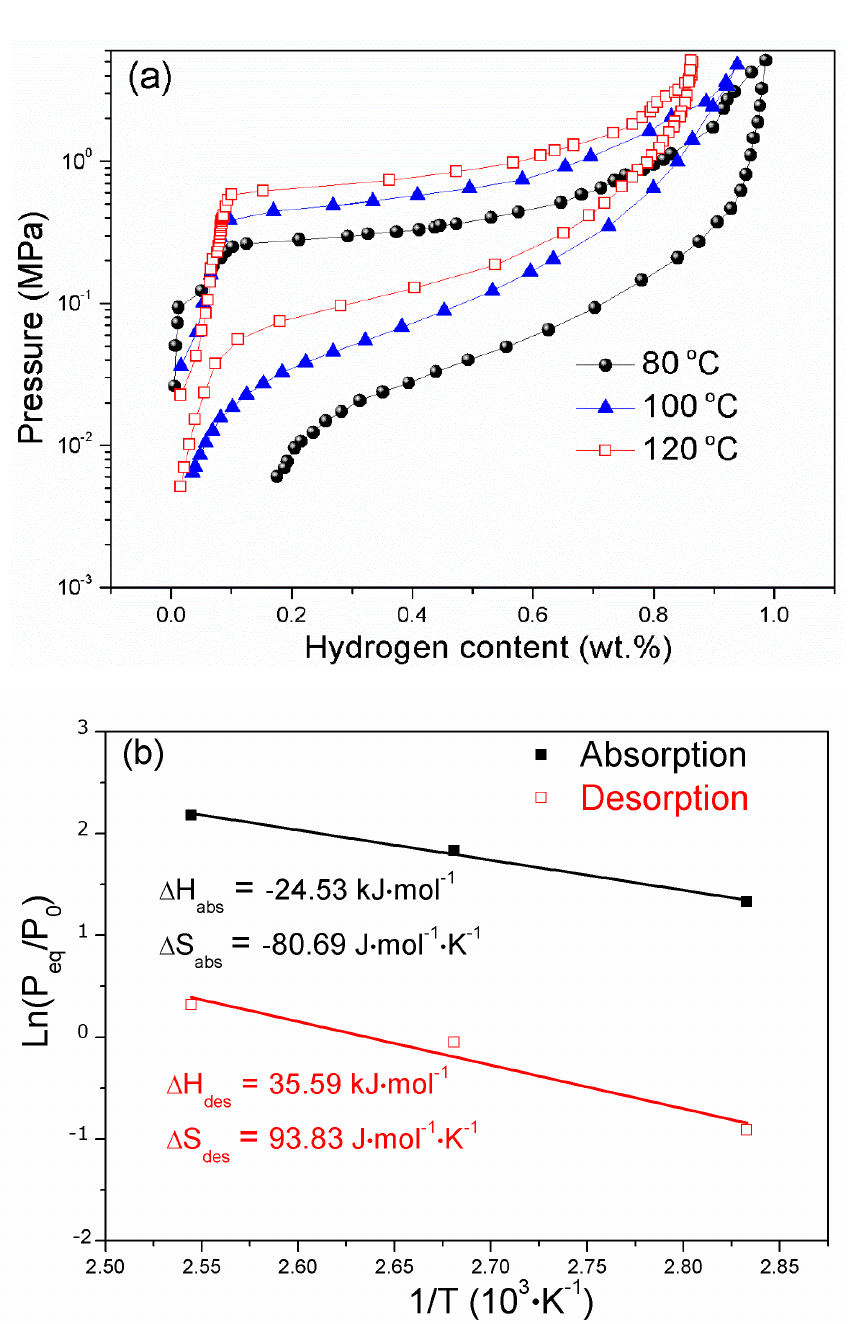
Figure 6. Hydriding and dehydriding pressure-composition isotherms (PCI) curves ( a ) and van’t Hoff plots ( b ) for Y 0.25 Sc 0.7 Ni 2 .